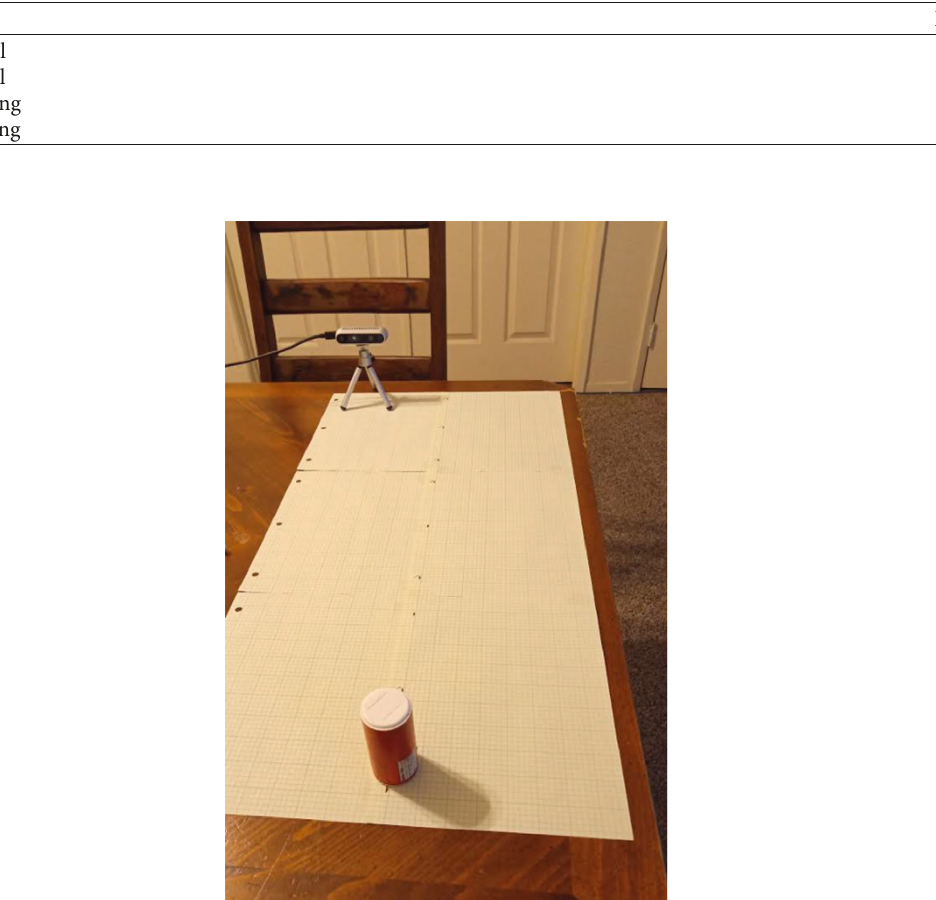
Figure 21: BCI stream selected points. Table 3: Camera input values.